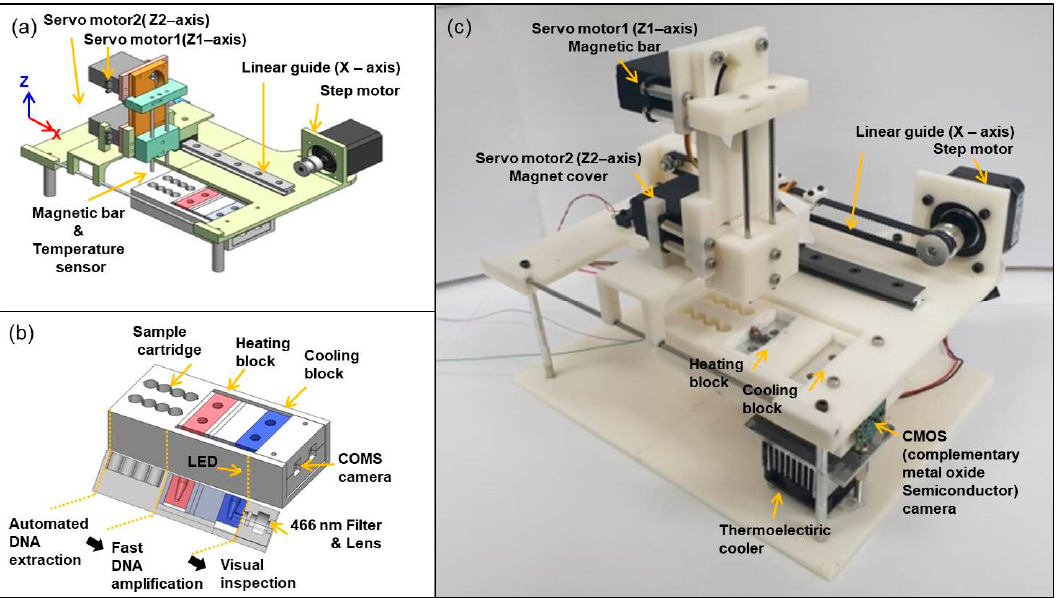
Figure 1. Schematic images of ( a ) whole system and ( b ) sample cartridge holder with cross-sectional view. ( c ) Photograph of automated fast PCR system.